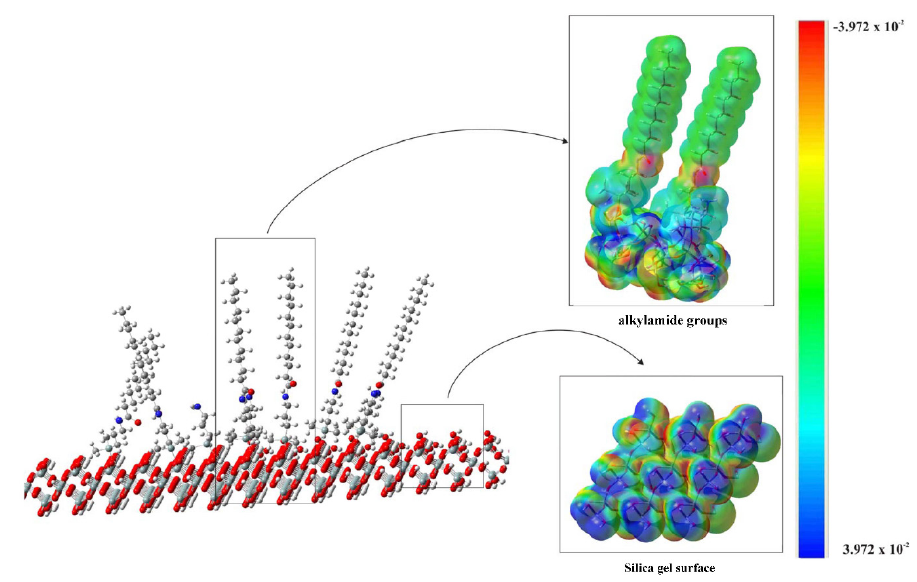
Figure 1: Structure of synthesized alkylamide stationary phase.